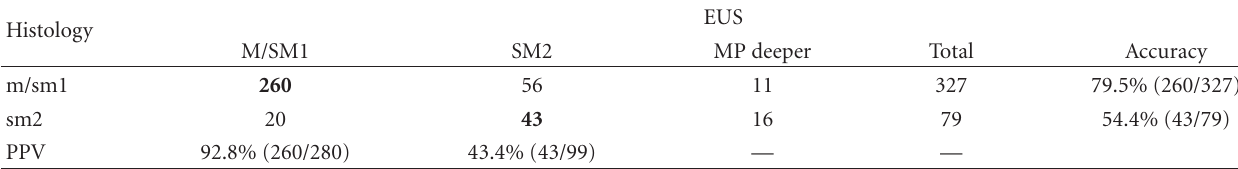
Table 2: Accuracy of cancer invasion depth as determined by endoscopic ultrasound.